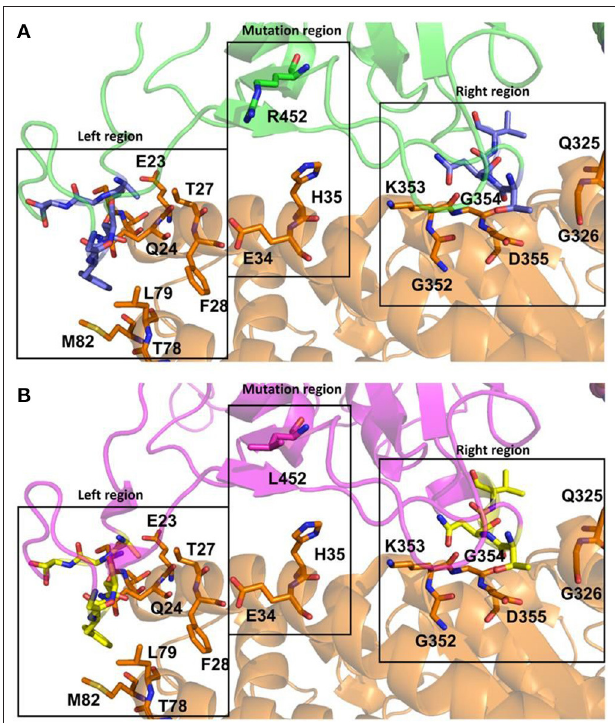
FIGURE 6 | The interaction regions between the SARS-CoV-2 Spike proteins and the ACE2 receptor (ribbons and sticks in orange). (A) . SARS-CoV-2 Spike protein for the P.4 lineage ( in silico model) is highlighted in green (ribbons and sticks, including the mutated residue), with important conserved residues in slate (sticks). (B) . SARS-CoV-2 Spike protein for the Wuhan glycoprotein (cryo-EM structure) is highlighted in magenta (ribbon and sticks, including the mutated residue), with important conserved residues in yellow (sticks). For all atoms presented in sticks, carbon atoms are shown in orange (ACE2) or green/slate/magenta/yellow (Spike proteins), nitrogen atoms are shown in blue, oxygen atoms are shown in red and all hydrogen atoms are omitted for clarity. The figure was generated using PyMol